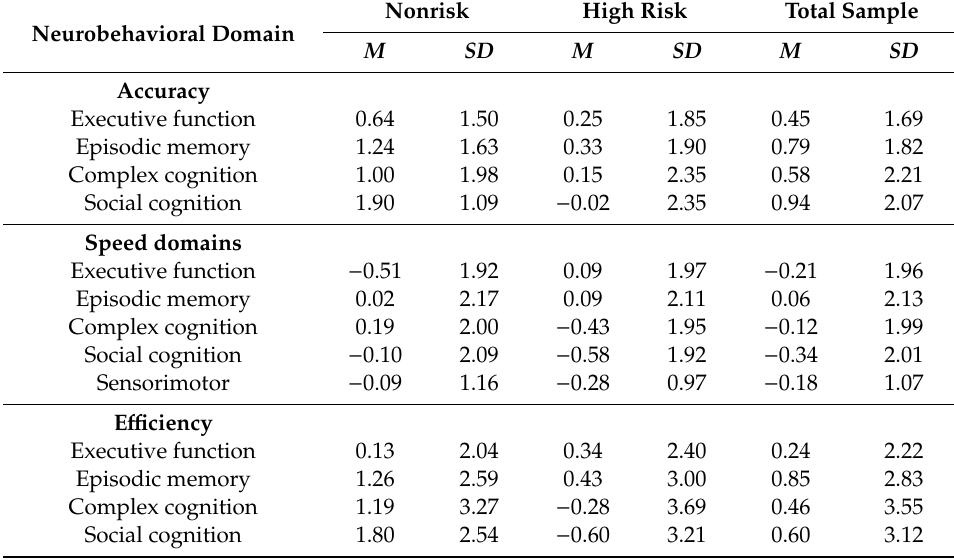
Table 1. Descriptive statistics for the total sample and the risk and no-risk groups for PWI–SC.